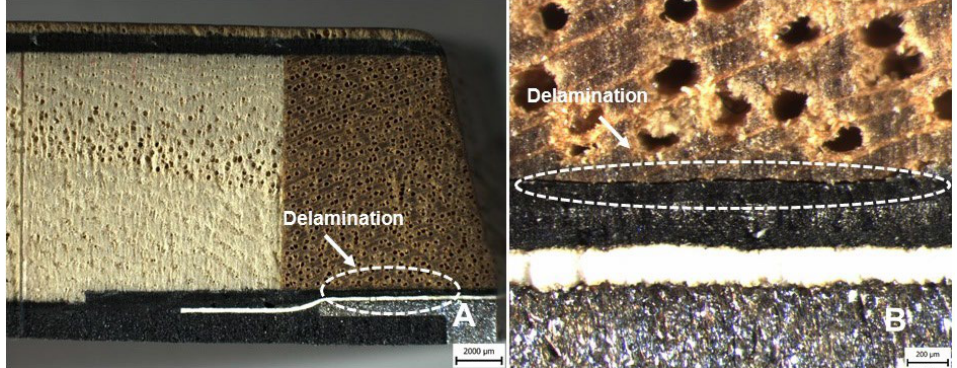
Figure 12. Cross-section of the hybrid sandwich ski structure after the end of long-term low-cycle fatigue, i.e., 70,000 cycles: ( A ): Macroscopic picture of delamination in the lower part of the ski at the interface of wood sidewalls (No. 9) and carbon triaxial (No. 11) (scale 2000 μm ) , ( B ): Microscopic picture of delamination in the lower part of the ski at the interface of wood sidewalls (No. 9) and carbon triaxial (No. 11) (scale 200 μm ) .